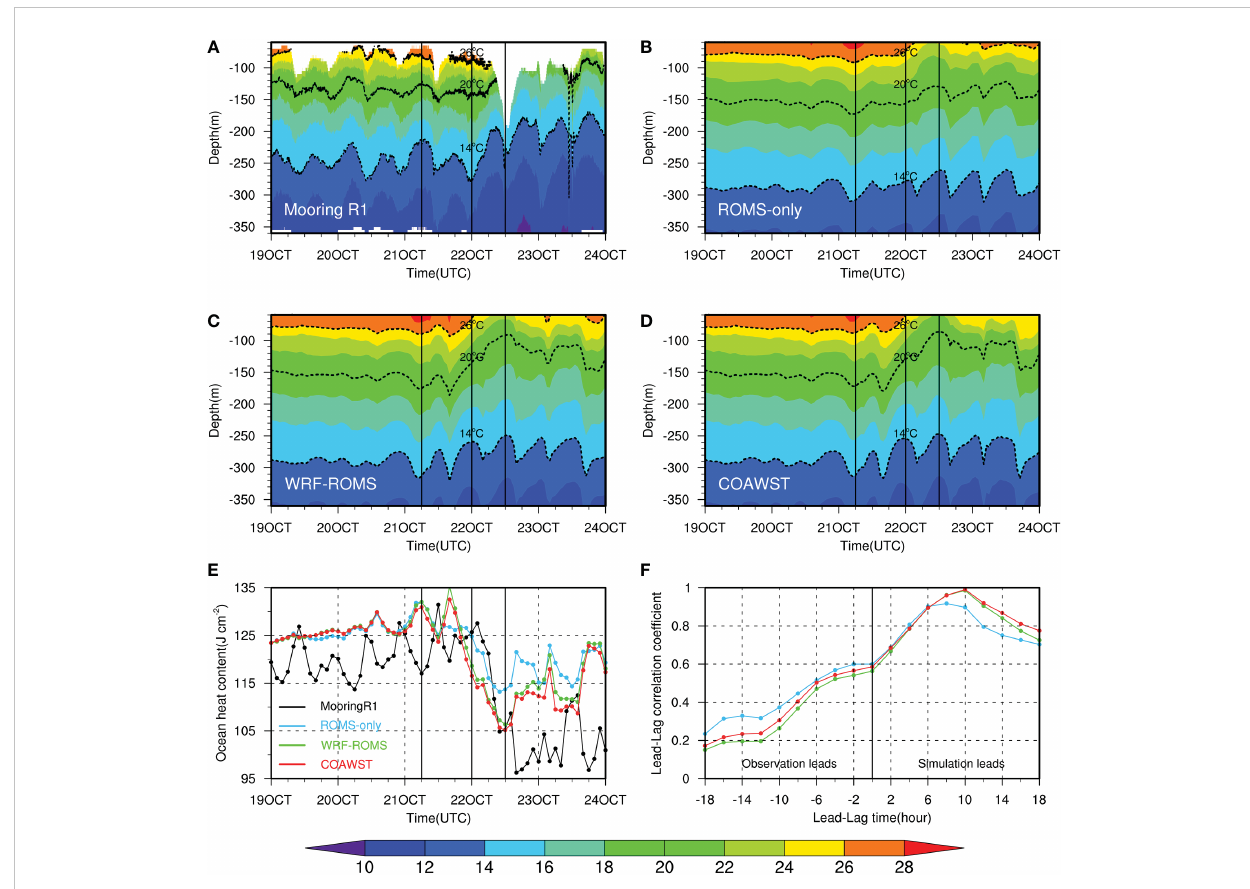
FIGURE 5 (A – D) Comparison of contours of temperature versus time and depth between (A) Mooring R1 and simulation (B) ROMS-only, (C) WRF-ROMS, and (D) COAWST at the position of mooring R1. The 14, 20, and 26°C isothermal lines are plotted and labeled. (E) Ocean heat content (units: J cm − 2 ) integrate between 60 m and 200 m at the position of mooring R1. (F) Lead-Lag correlation coef fi cient between experiments and the observation. Vertical lines in (A – E) indicate the times during Megi ’ s approaching, arriving, and passing